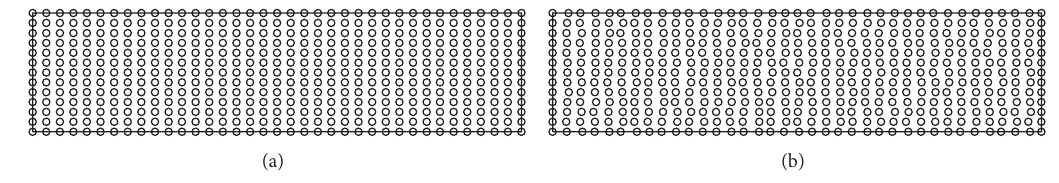
Figure 3: Typical node distribution: regular 37 × 13 nodes (a); irregular 481 nodes (b).